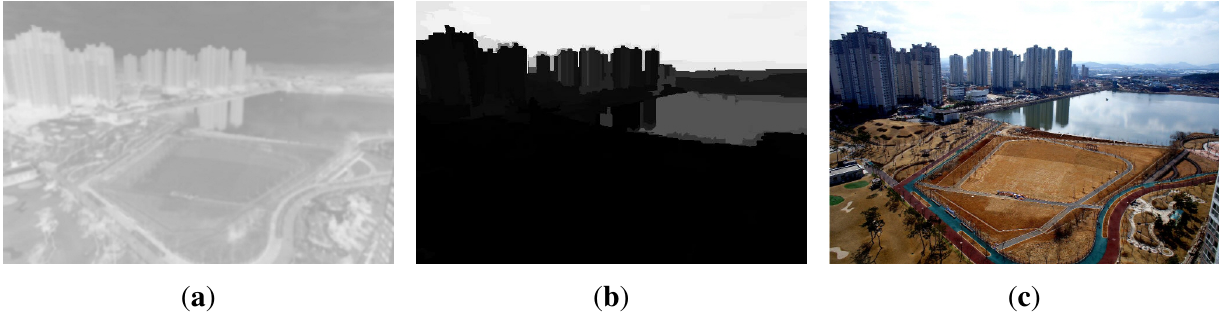
Figure 8. Results of dehazing: ( a ) the transmission map using the proposed method; ( b ) the labeled sky image using the proposed segmentation method; and ( c ) the dehazed image using the proposed modified transmission map and atmospheric